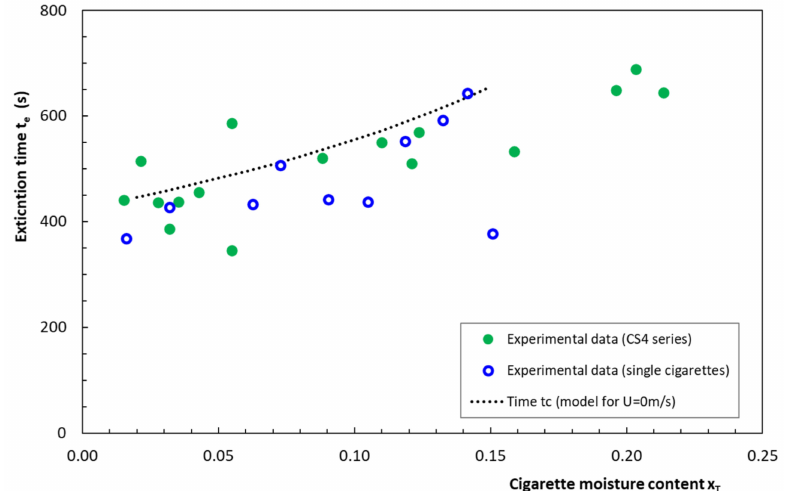
Figure 10. Values of cigarettes extinction time t e as a function of cigarettes moisture value x T on fuel beds with constant value of fuel moisture content x (Series CS4). The dotted line corresponds to t c computed for single cigarettes using Equation (45) for U = 0 m.s − 1